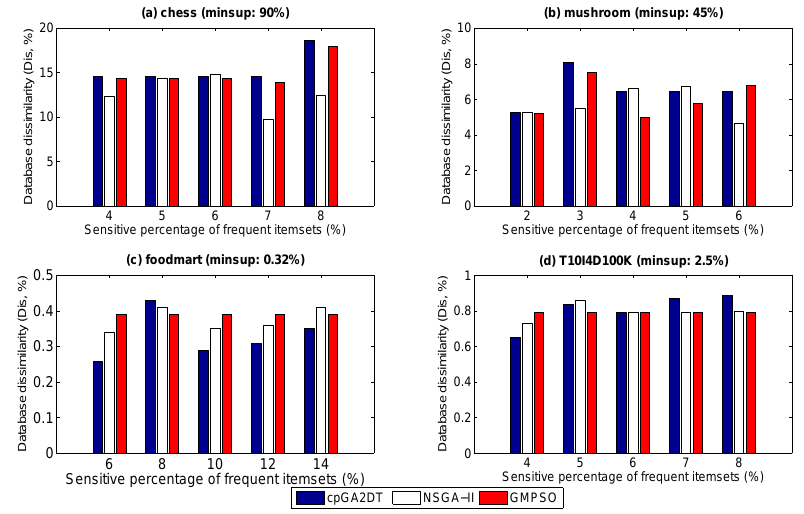
Figure 7. Database dissimilarity under varied percentages of